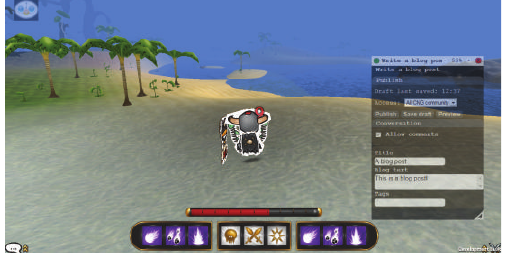
Figure 4: RedBedlam’s “The Missing Ink” game with integrated CNG collaboration tools, where widget panes are in vertical alignment.